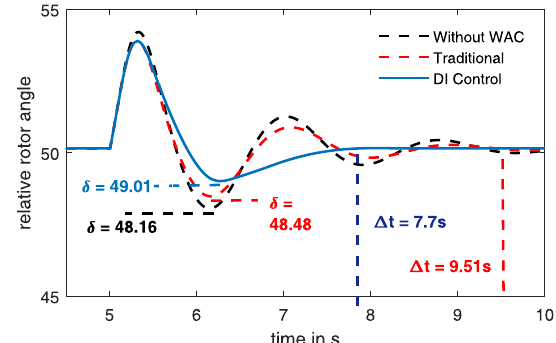
Fig. 7 Relative rotor angle deviations for a three-phase fault with a fault resistance of 0.001